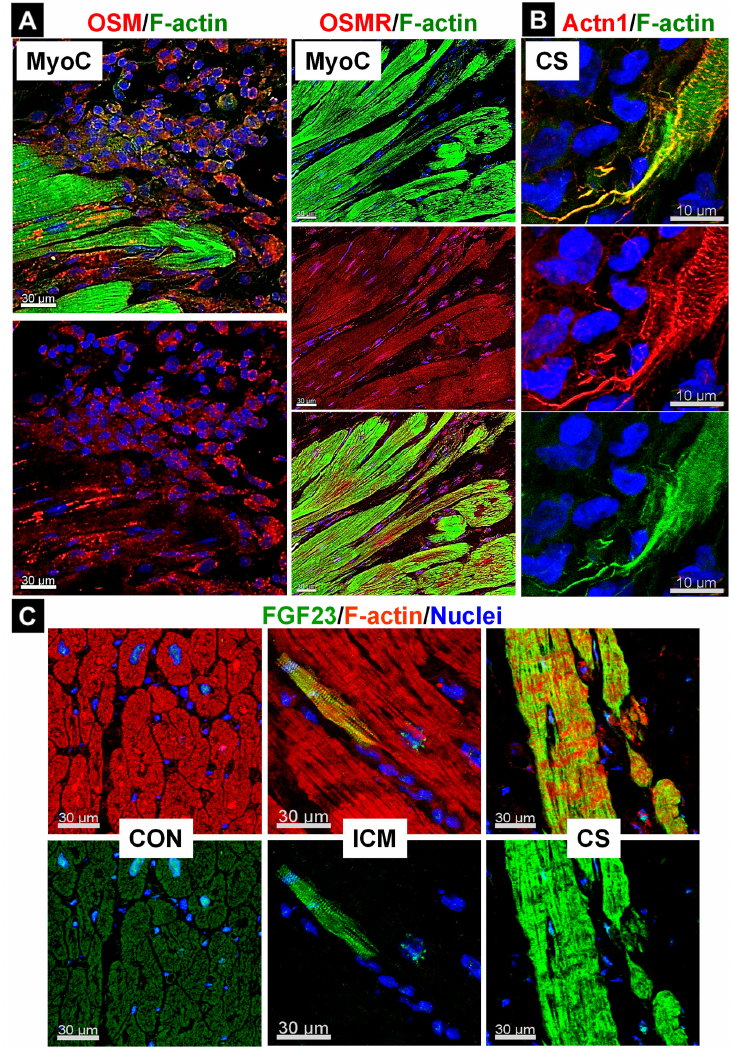
Figure 4. Infiltration of OSM-releasing cells is associated with fetal remodeling, increased expres- sion of the OSMR, and secreted proteins in the human myocardium. MyoC indicates myocarditis, CS is cardiac sarcoidosis, ICM means ischemic cardiomyopathy, and CON represents human con- trol tissue. Actn1 is non-muscle α -actinin-1 (Actn1). ( A ) Increases in OSM-positive infiltrates (mainly macrophages) are consistent with an increased expression of the OSMR in cardiomyocytes. ( B ) In- creased dedifferentiation characterizes fetal remodeling (image is modified from [13] ). Note the strong and thin cardiomyocyte elongation. ( C ) Both single FGF23-positive and clusters of positive cardiomyocytes can be identified. OSM is currently the only known cytokine that induces FGF23 expression in cardiomyocytes.